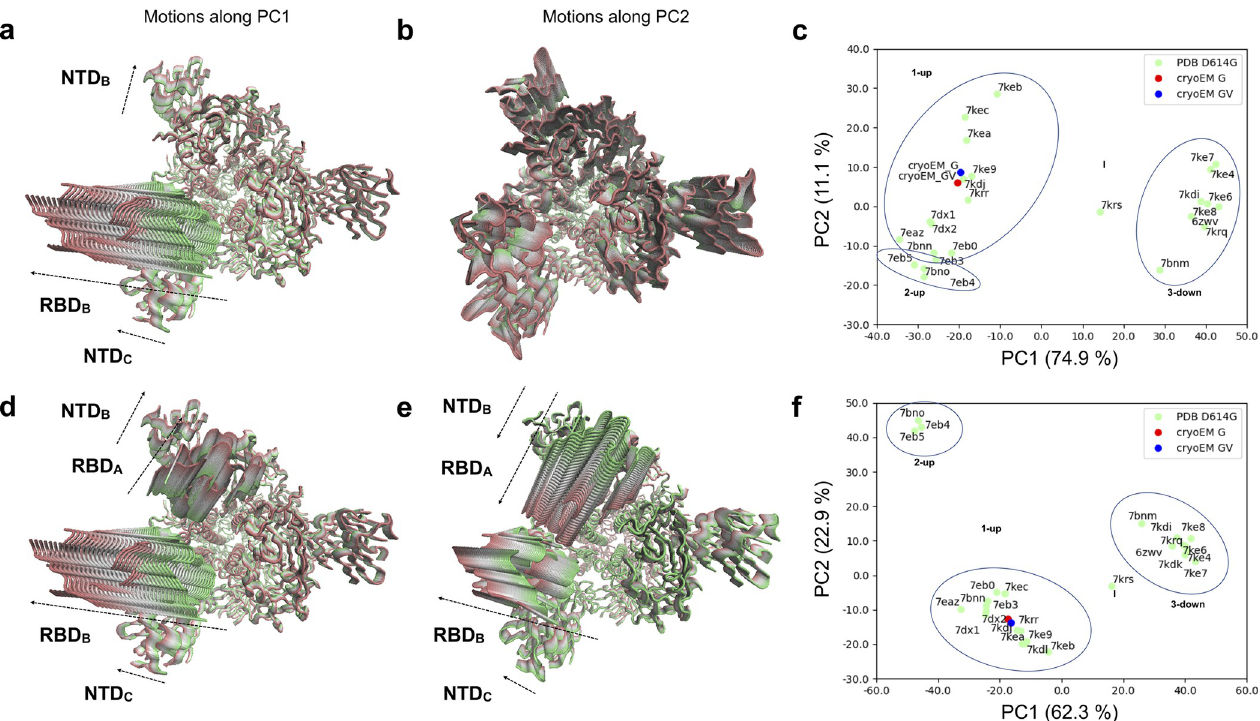
Fig 8. PCA for PDB-reported S:D614G single mutant. PCA results for the whole spike excluding (a-c) and including the 2-up conformations (d-f) in the covariance calculation. (a) Conformational evolution showing RBD opening motions observed in PC1 of the whole spike excluding 2-up conformations is shown from a top view ranging from a closed state (green) to an open state (red). (b) Conformational evolution along PC2 of the whole spike excluding 2-up conformations is shown from a top view from one extreme in green (compressed state) to the other in red (stretched state). Different domains move differently besides the compression and stretching of the structure. (c) Projection of the PDB S:D614G structures (green) and our cryo-EM structures (red and blue) onto the space of the first two PCs of the whole spike excluding 2-up conformations. Note a flipping of PC1 in this analysis relative to the PCAs from MD ensembles. (d) Concerted RBD opening motions observed in PC1 of the whole spike including 2-up conformations are shown from a top view ranging from one extreme in green (closed state) to the other in red (open state). (e) Anticorrelated RBD opening motions observed in PC2 of the whole spike including 2-up conformations are shown from a top view ranging from one extreme in green (closed state) to the other in red (open state). (f) Projection of the PDB S:D614G structures (green) and our 1-up cryo-EM structures (red and blue) onto the space of the first two PCs of the whole spike including 2-up conformations.